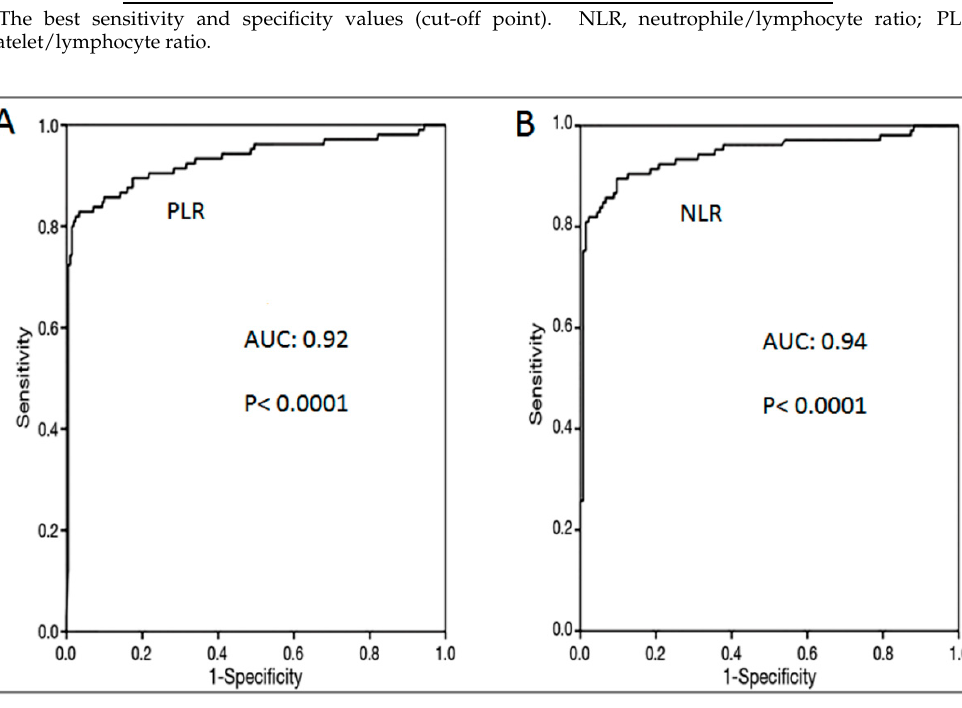
Figure 3. ( A ) ROC curve for using PLR (platelet/lymphocyte ratio) levels in the differential diagnosis of Group 1 (lung cancer patients) and Group 2 (control cases); ( B ) ROC curve for using NLR (neutrophil/lymphocyte ratio) levels in the differential diagnosis of Group 1 and Group 2.